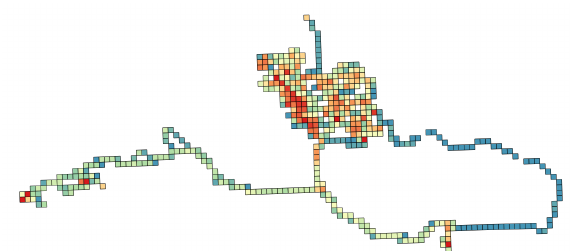
Figure 13: Generalisation of the GPS trajectories - points inside the particular cell are counted and treated as the density of partic- ular grid showing density of movements of